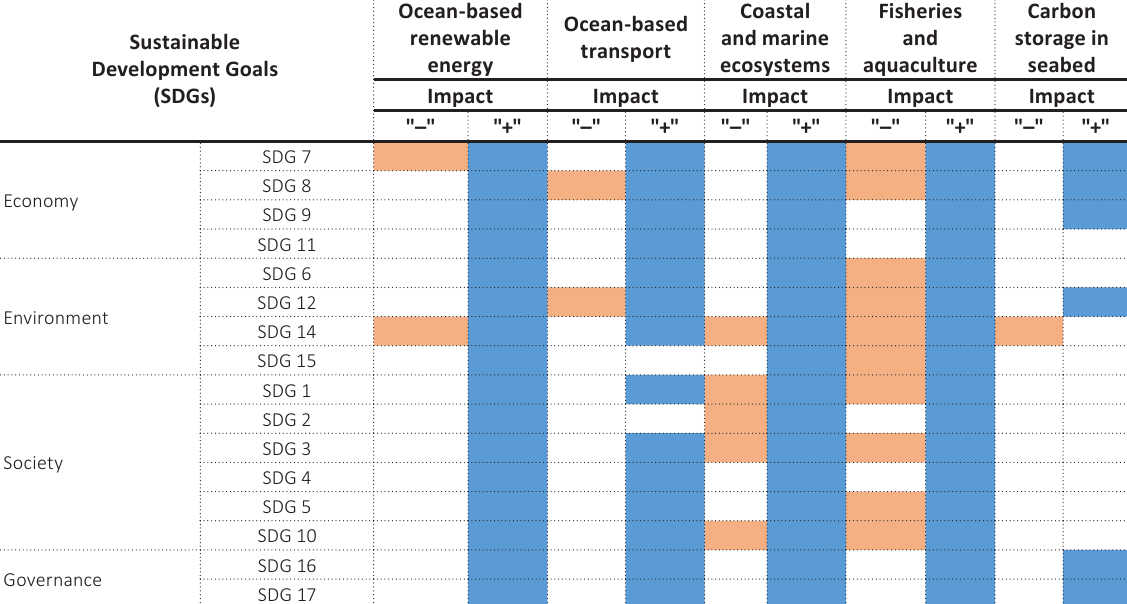
Table 2. Set of indicators reflecting the level of sustainable development in the maritime